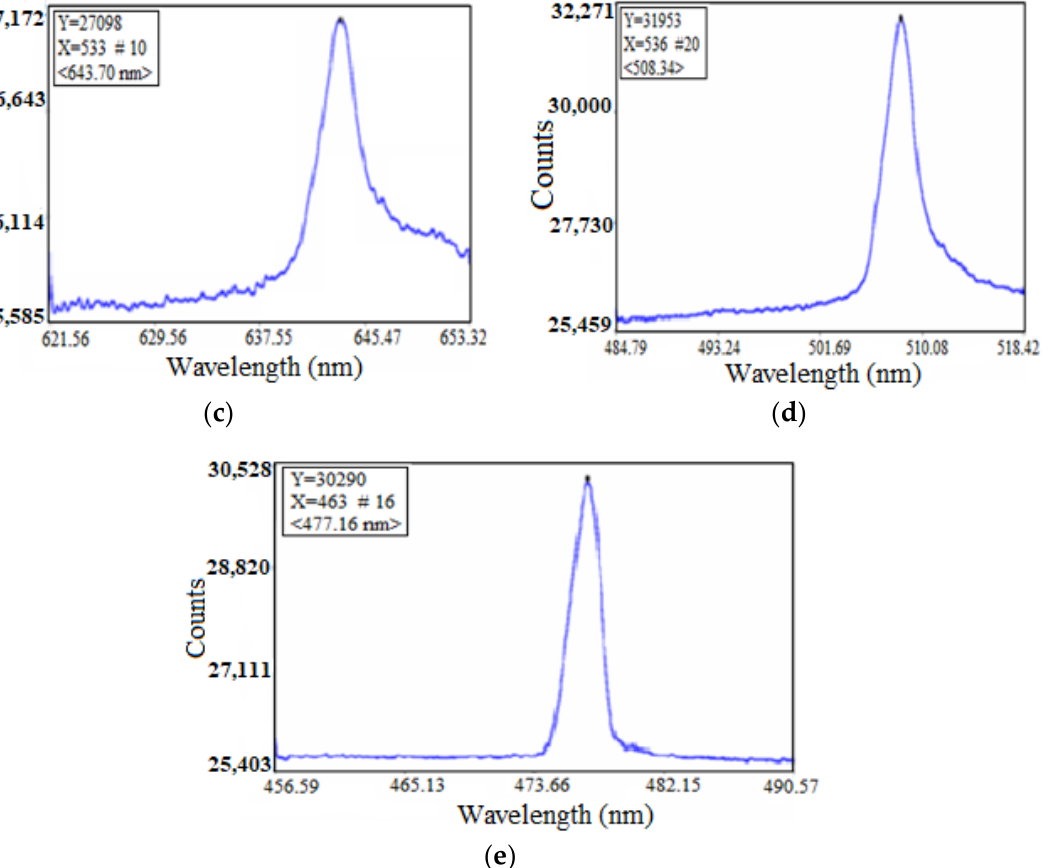
Figure 11. ( a – e ) Plasma with different spectral line during the deposition. ( a ) 348.2 nm; ( b ) 467.73 nm; ( c ) 508.34 nm; ( d ) 643.70 nm; and ( e ) 477.16 nm. The image profile and three-dimensional profile of the spectral line 477.16 nm are shown in Figure 12a,b.